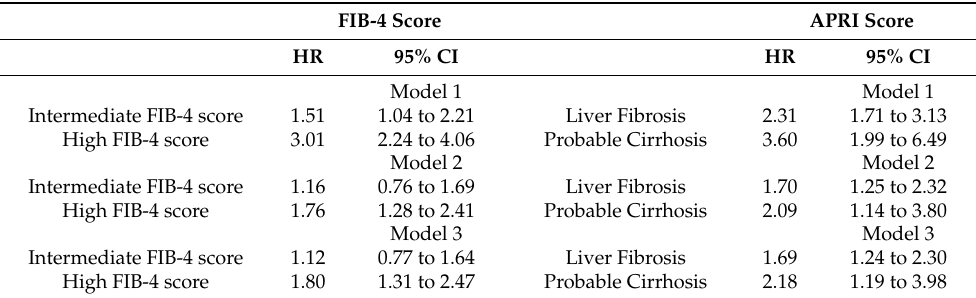
Table 2. Cox multivariable regression nested models on each fibrosis-4 (FIB-4) score risk category (low-, intermediate-, and high-risk).